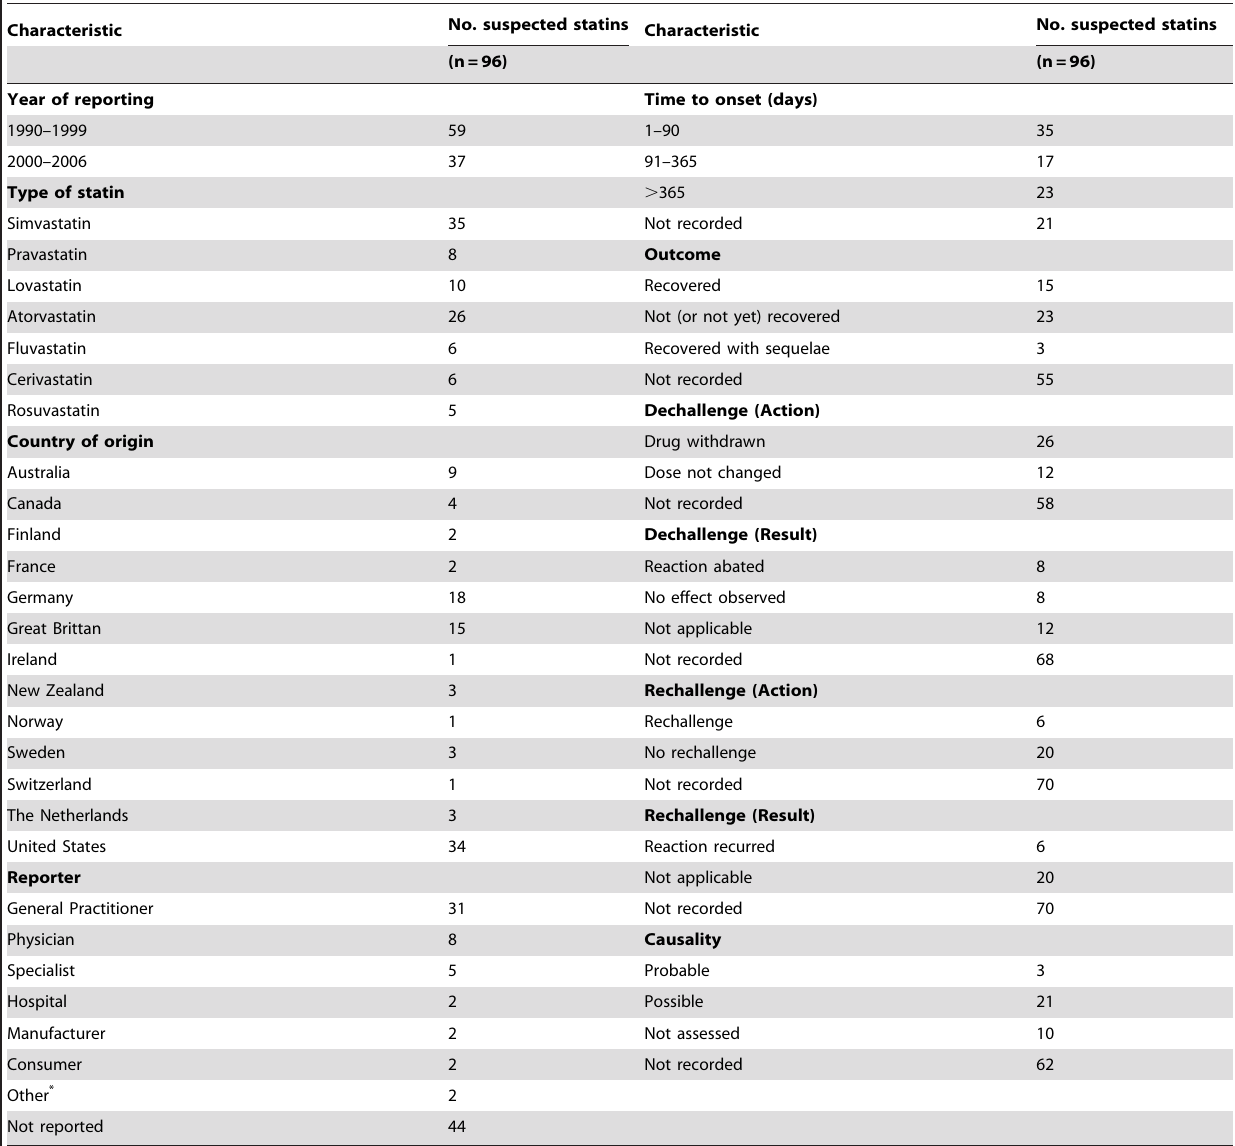
Table 2. Detailed information on the 96 case reports with statins as suspected